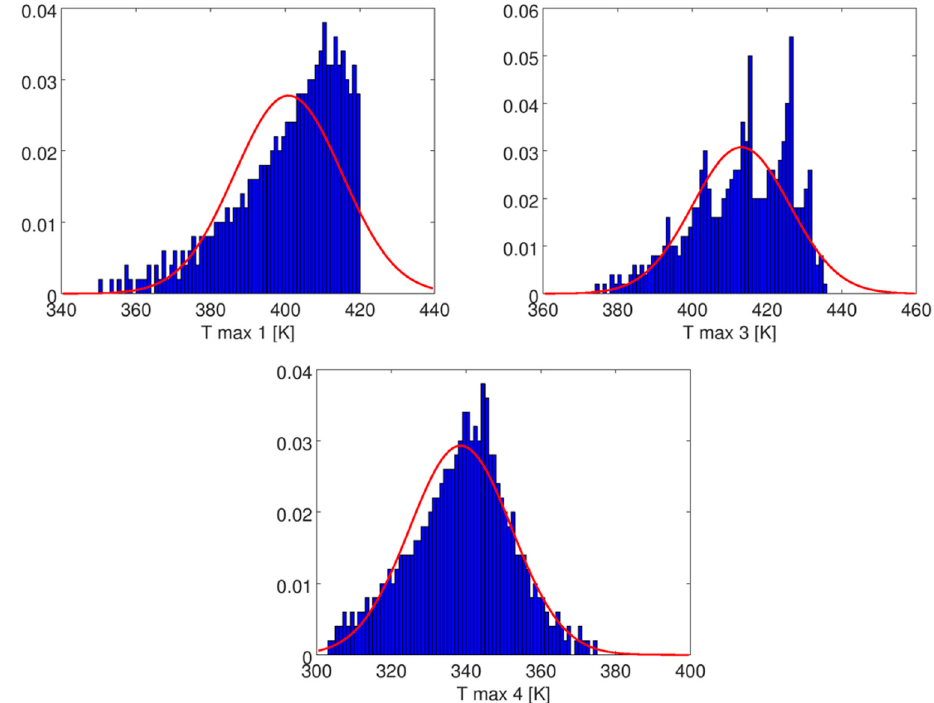
Figure 18. Pdf of maximum temperature with normal input distribution of vf.